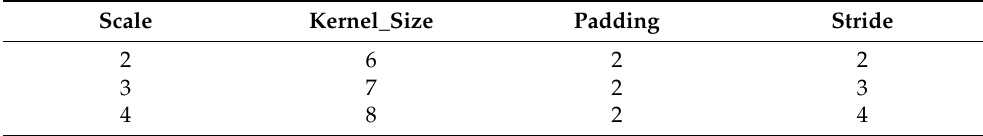
Table 1. Different scaling factors correspond to different kernel_size, padding, stride.